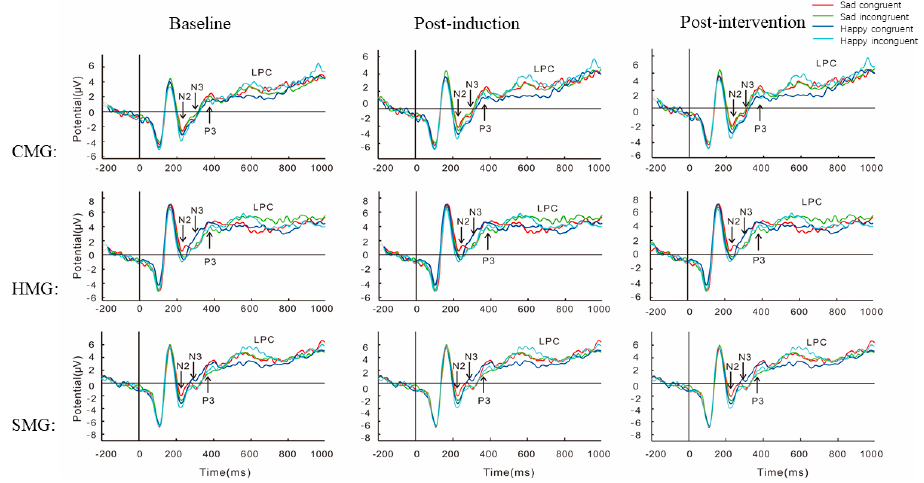
Figure 7. Grand average waveforms of N2, N3, P3, and late positive component (LPC) at site Fz in the face–word Stroop task. CMG: calm music group, HMG: happy music group, SMG: sad music group.